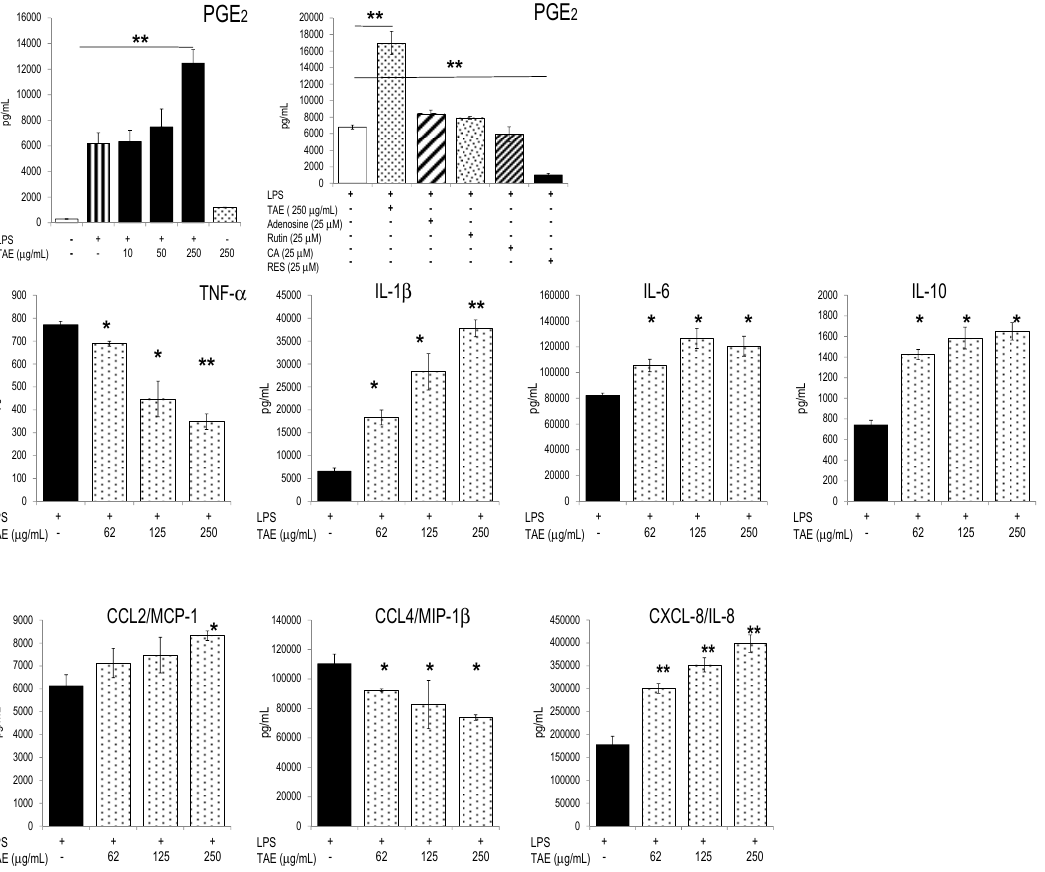
Figure 3. Effects of TAE on activated human PBLs. Freshly isolated PBLs were incubated with TAE, stimulated with LPS and cultured for 24 h. Representative data (±SD) of duplicates from one of three independent experiments are given. * p < 0.05, ** p < 0.01 ( vs. LPS-stimulated cells). RES, resveratrol.